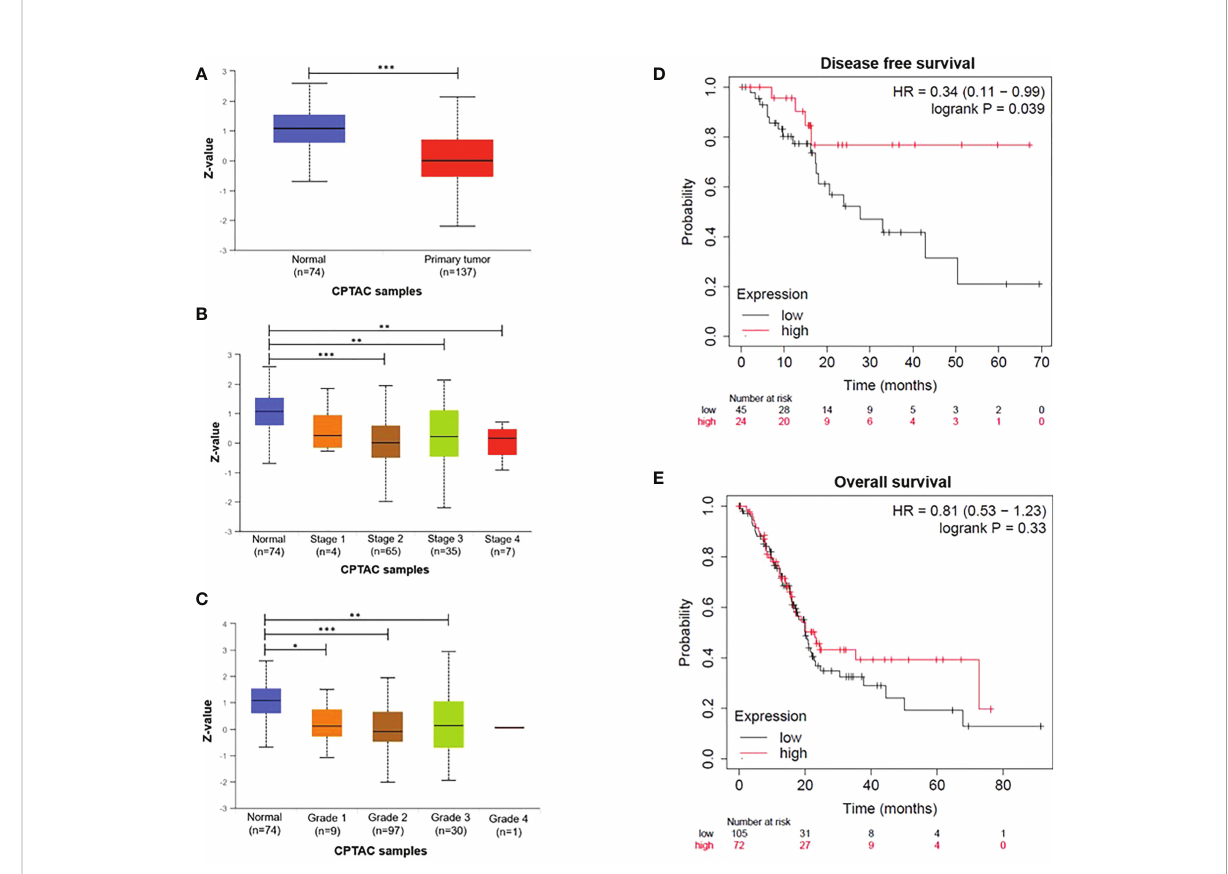
FIGURE 1 DDB2 expression in PDAC patients (A) DDB2 total protein expression in normal tissues (n= 74) and in primary tumors (n= 137), (B) Relationship between DDB2 protein expression and tumor stages, (C) Relationship between DDB2 protein expression and tumor grades. Data are expressed as mean ± SE, *p < 0.05, **p < 0.01, ***p < 0.001. Protein expression level was expressed as a Z-value, was log2 normalized in each sample, then a Z-value for each sample was calculated as a standard deviation from the median across samples. (D) Representative Kaplan-Meier of dis- ease-free survival (DFS) of PDAC patients (n=69) strati fi ed according to DDB2 expression in tumors (log rank p= 0.039) (E) Representative Kaplan-Meier of overall survival (OS) of PDAC patients (n=177) strati fi ed according to DDB2 expression in tumors (log rank p=